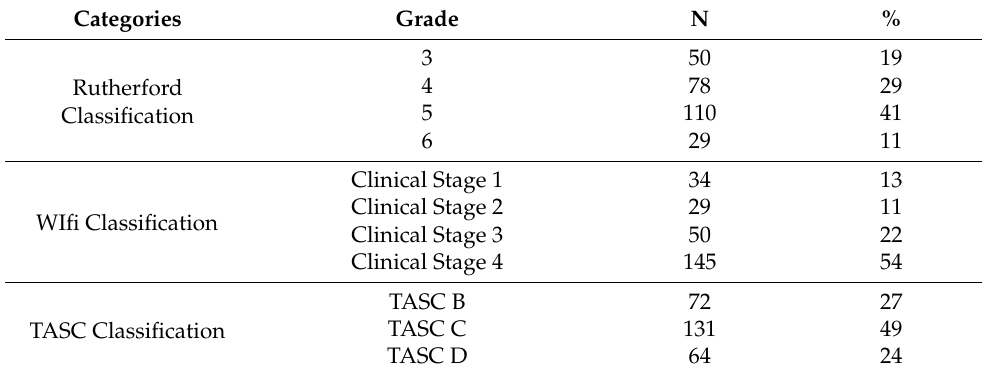
Table 3. Clinical presentation and anatomic findings.